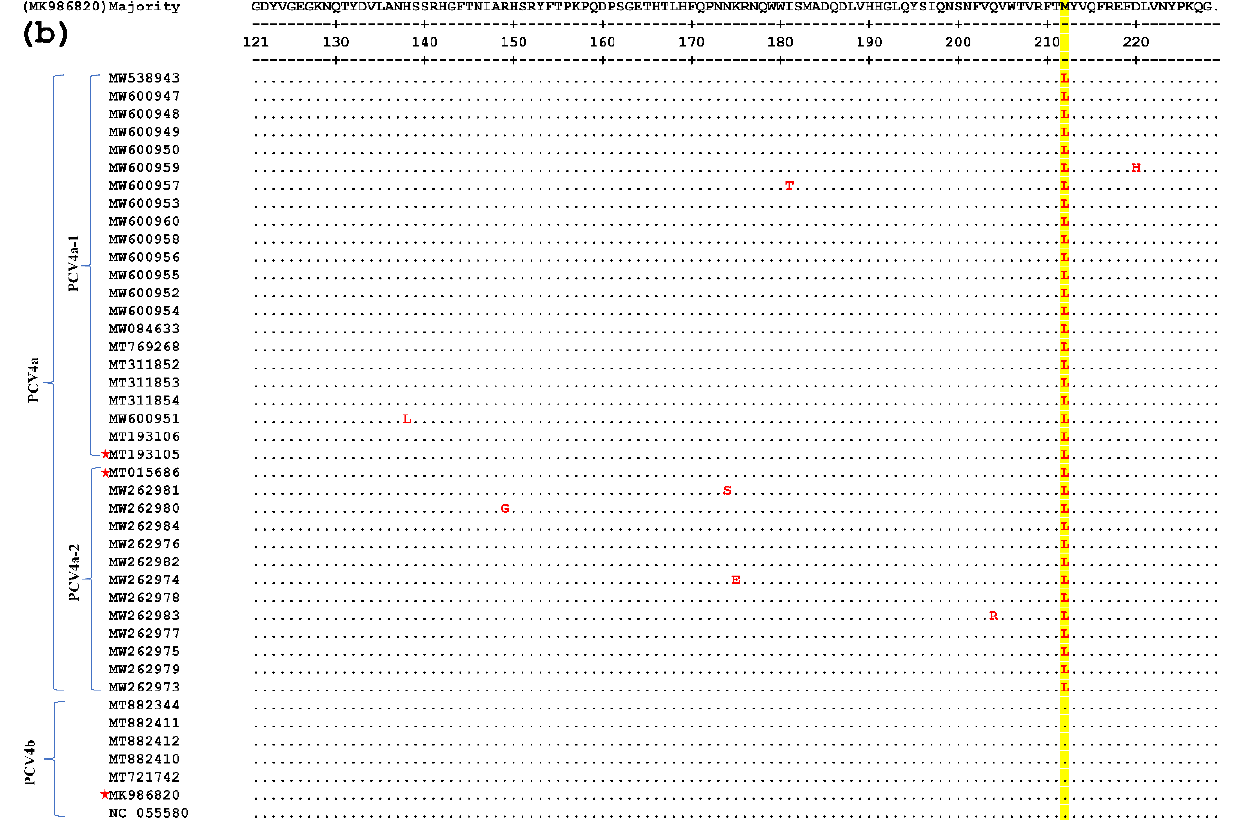
Figure 3. Comparative amino acid analysis of the Cap proteins of PCV4. Strain MK986820 was the standard strain, and three strains annotated with a pentagram were the representative sequences screened in this study. Residues are indicated by dots if fully consistent.